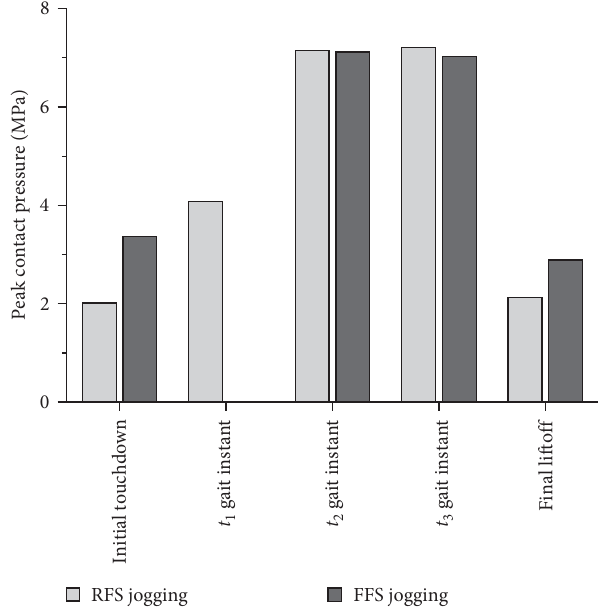
F IGURE 11: Peak contact pressure of talocalcaneal joint